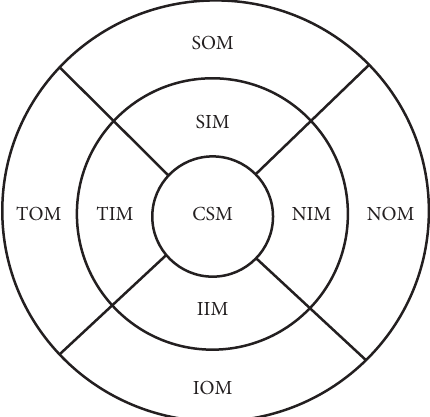
Figure 1: Illustration of the measurement of macular choroidal thickness at nine locations. (reproduced from Fan Li et al. [21]) . CSM, central subfield macula; NIM, nasal inner macula; SIM, superior inner macula; IIM, inferior inner macula; TIM, temporal inner macula; NOM, nasal outer macula; SOM, superior outer macula; IOM, inferior outer macula; TOM, temporal outer